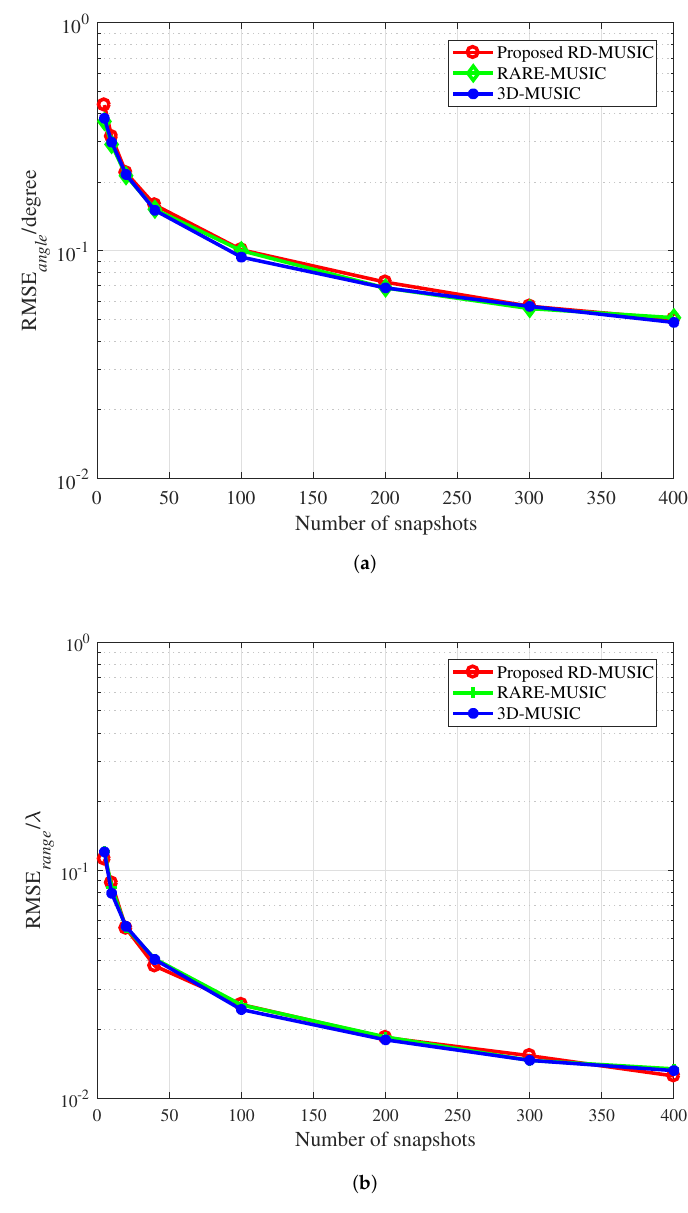
Figure 4. RMSEs versus the number of snapshots. ( a ) DOA estimation. ( b ) Range estimation. In order to evaluate the robustness of the proposed algorithm, its performance with uniform inter-element spacing d and coprime inter-element spacing is compared for the identical subarray aperture, as shown in Figure 5, where the aperture of the subarray for each axis is D = 16 d , the coprime factor pairs are a 1 = 7, b 1 = 8, and a 2 = 3, b 2 = 4, and the source is located at ( θ , ϕ , r ) = ( 35.3 ◦ , 58.6 ◦ , 20 λ ) . Estimation results for the SSCA structure and USCA structure are presented in Figure 5, where it can be seen that the proposed SSCA outperforms the USCA with the same subarray aperture. Moreover, when the